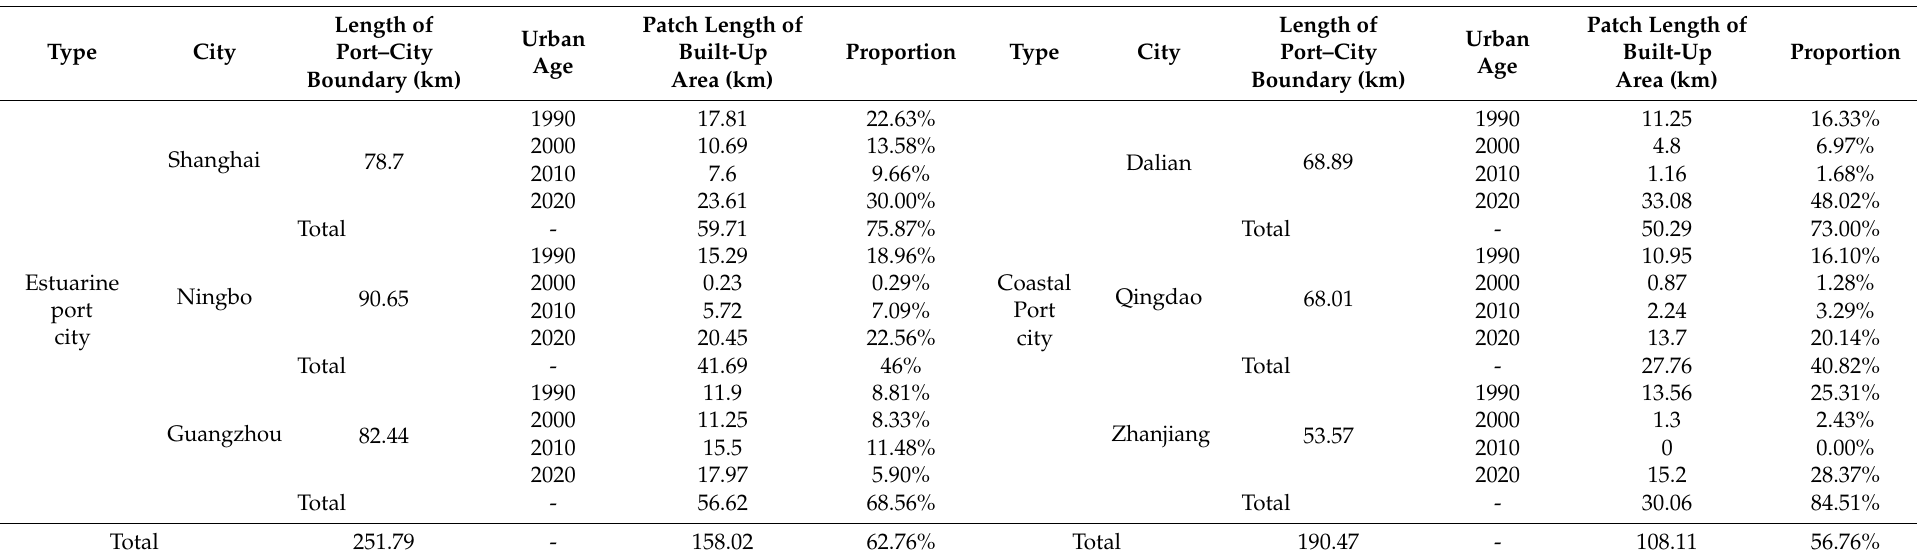
Table 1. Patch length of built-up area formed in different years on the port–city